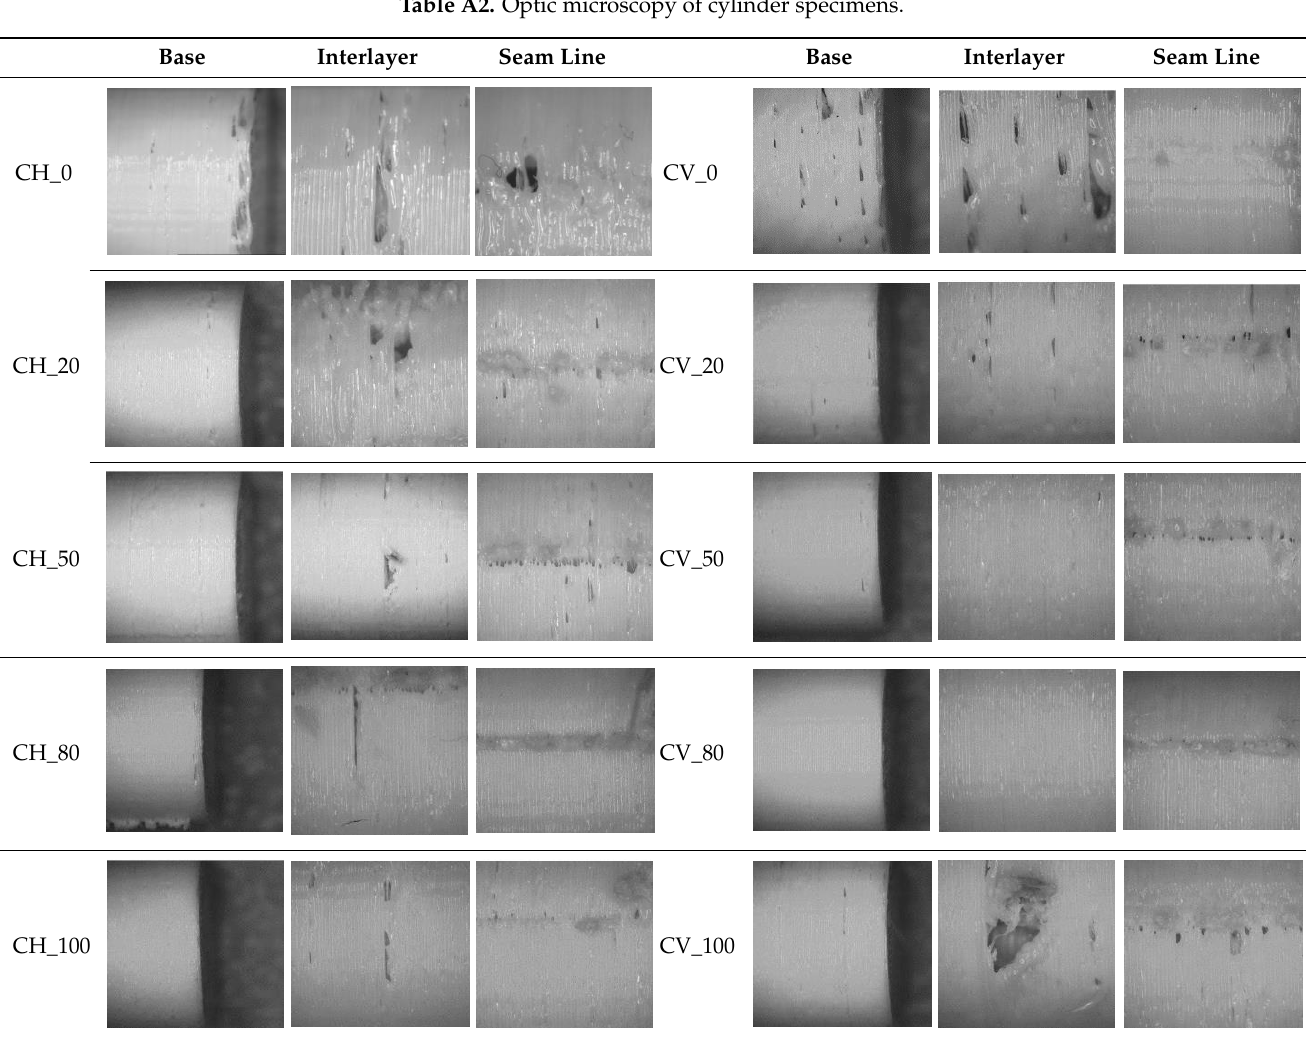
Table A2. Optic microscopy of cylinder